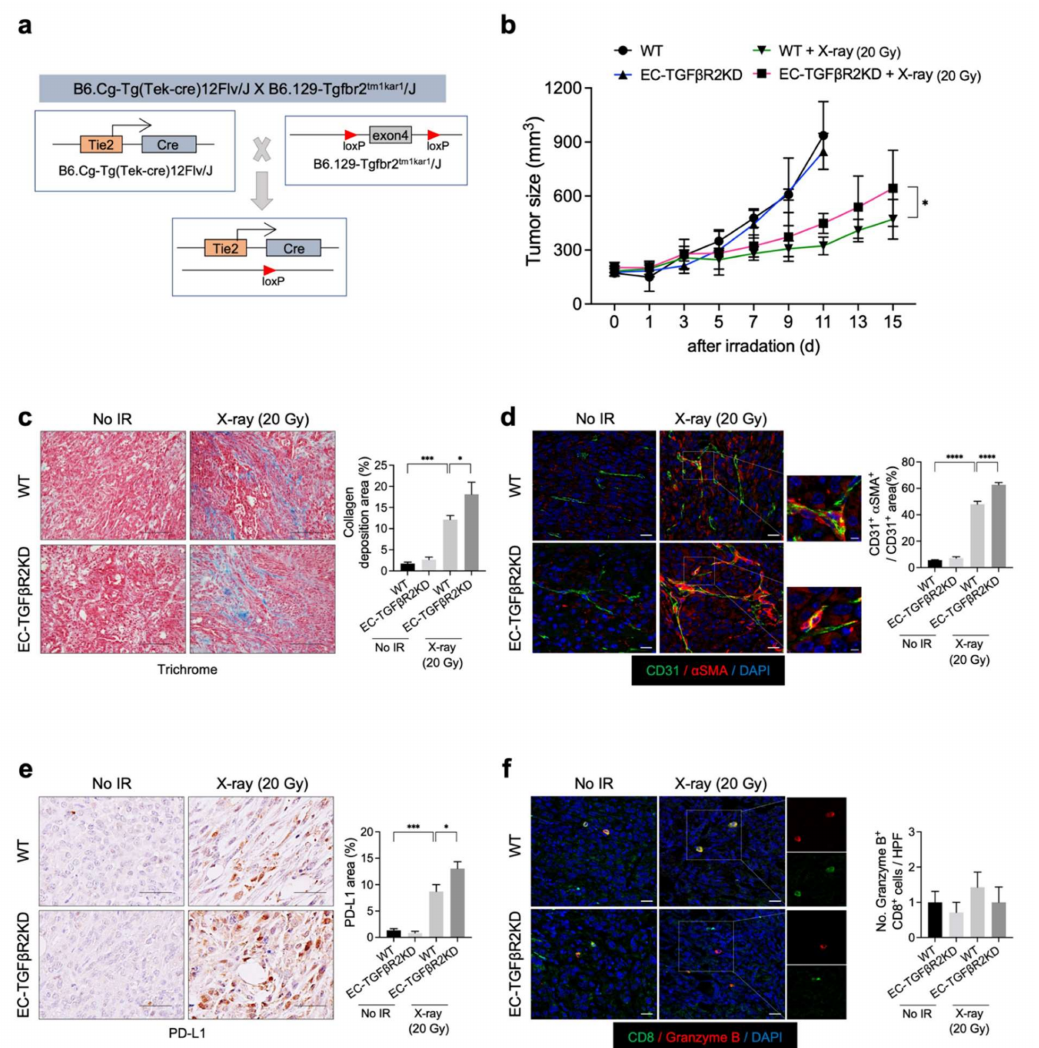
Figure 5. Endothelial-specific TGF β R2 knockdown enhances KP tumor regrowth, collagen deposition, EndMT, and PD-L1 expression, but not cytotoxic T-cell infiltration, after X-ray irradiation. ( a ) Schematic diagram of the endothelial-specific TGF β R2 exon4 knockdown. Tgfbr +/flox (WT) and Tie2 -Cre; Tgfbr2 +/flox (EC-TGF β R2KD) mice were subcutaneously injected with KP cells in the right thigh. Non-irradiated tumor tissues obtained on day 0 and irradiated tumor tissues obtained on day 15 after irradiation were used for staining. ( b ) WT and EC-TGF β R2KD tumor growth in irradiated and non-irradiated mice. Irradiation was performed when tumor tissues reached 150–200 mm 3 . Non-irradiated tumor tissues were obtained on days 0 and 11 after irradiation, and irradiated tumor tissues were obtained on day 15 after irradiation ( n = 5–6 animals per group). Error bars indicate the SD (two-way ANOVA for multiple comparison). ( c ) Trichrome staining of KP tumors from irradiated or non-irradiated WT and EC-TGF β R2KD mice. Scale bar = 20 µ m. Quantification of collagen deposition area per field as an average of five fields (magnification, 200 × , n > 5). ( d ) Immunofluorescence staining of CD31 (green) and α SMA (red) expression in irradiated or non-irradiated KP tumors from WT and EC-TGF β R2KD mice. Scale bar = 20 µ m; scale bar of cropped images = 5 µ m. Quantification of the α SMA + CD31 + colocalization area per CD31 + area as an average of five fields (magnification, 200 × , n > 5). ( e ) Immunohistochemistry of PD-L1 (brown color) in irradiated or non-irradiated KP tumors from WT and EC-TGF β R2KD mice. Scale bar = 20 µ m. Quantification of PD-L1 area per field as an average of five fields (magnification, 200 × , n > 5). ( f ) Immunofluorescence staining of CD8 (green) and granzyme B (red) cells in irradiated and non-irradiated KP tumors from WT and EC-specific TGF β R2KD mice. Scale bar = 20 µ m. Quantification of an average of five fields with a prominent CD8 + granzyme B + cell population per field (magnification, 200 × , n > 5). For graphs (c–f), error bars indicate the SEM (one-way ANOVA for multiple comparisons). * p < 0.05, *** p < 0.001, and **** p <